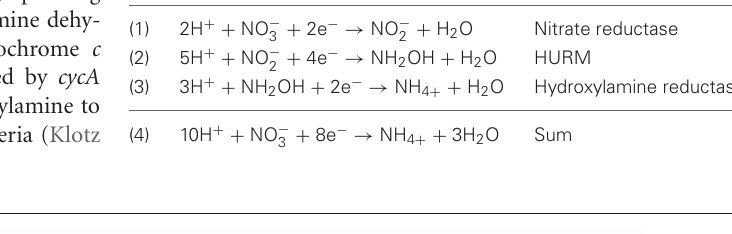
electrons donated from a tetra-heme cytochrome c in the NapC/ NrfH/ c M 552 family (CycB, 0559). (C) Transport of hydroxylamine via ammonia transporters related to AmtB. (D) Reduction of hydroxylamine to ammonium by a hybrid cluster protein/hydroxylamine reductase (Hcp/Har, 1074) utilizing reducing power from a predicted Fe-S containing protein (1302) whose electron donor (X) is currently